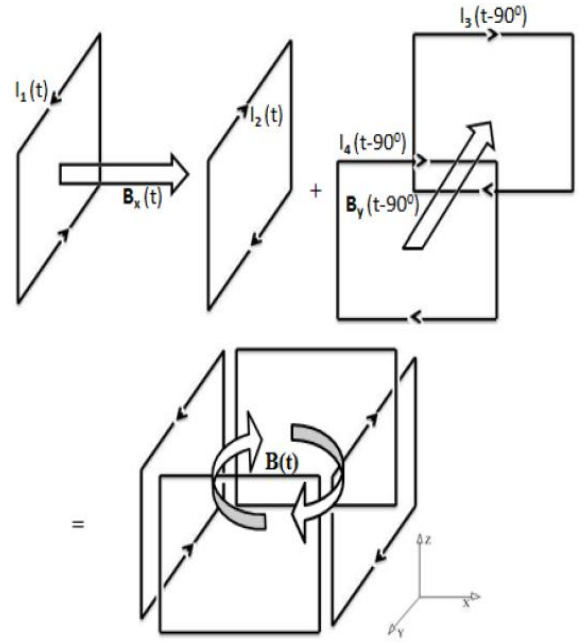
Figure 5: Horizontal field conceptual box.